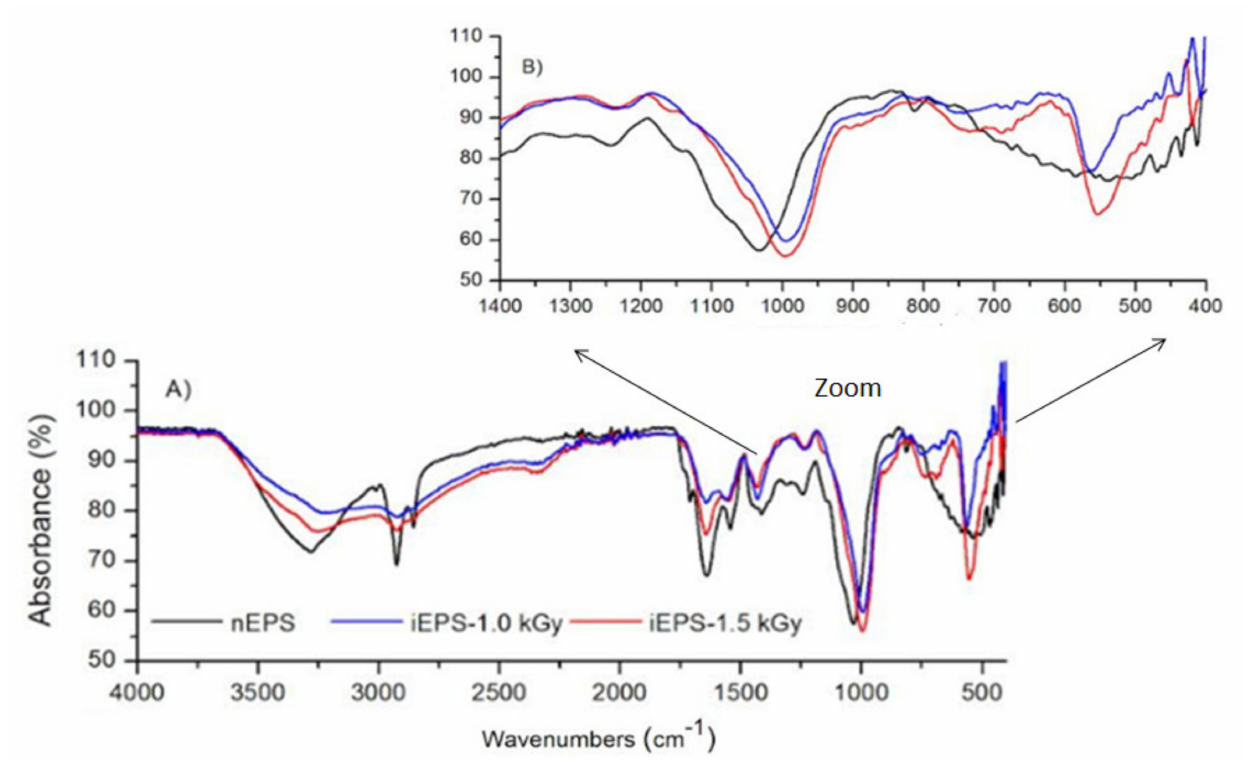
Figure 5. FTIR spectra of ( A ) native exopolysaccharide nEPS, gamma-irradiated exopolysaccharide iEPS–1.0 and iEPS–1.5 kGy over a wavenumber range of 400–4000 cm − 1 , and ( B ) fingerprint region with peaks in the 1400 to 400 cm − 1